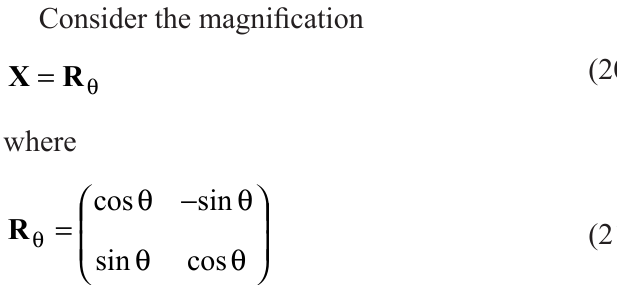
10    = X . The magnification can be in - 00 { 180 } 1 { 90 } followed